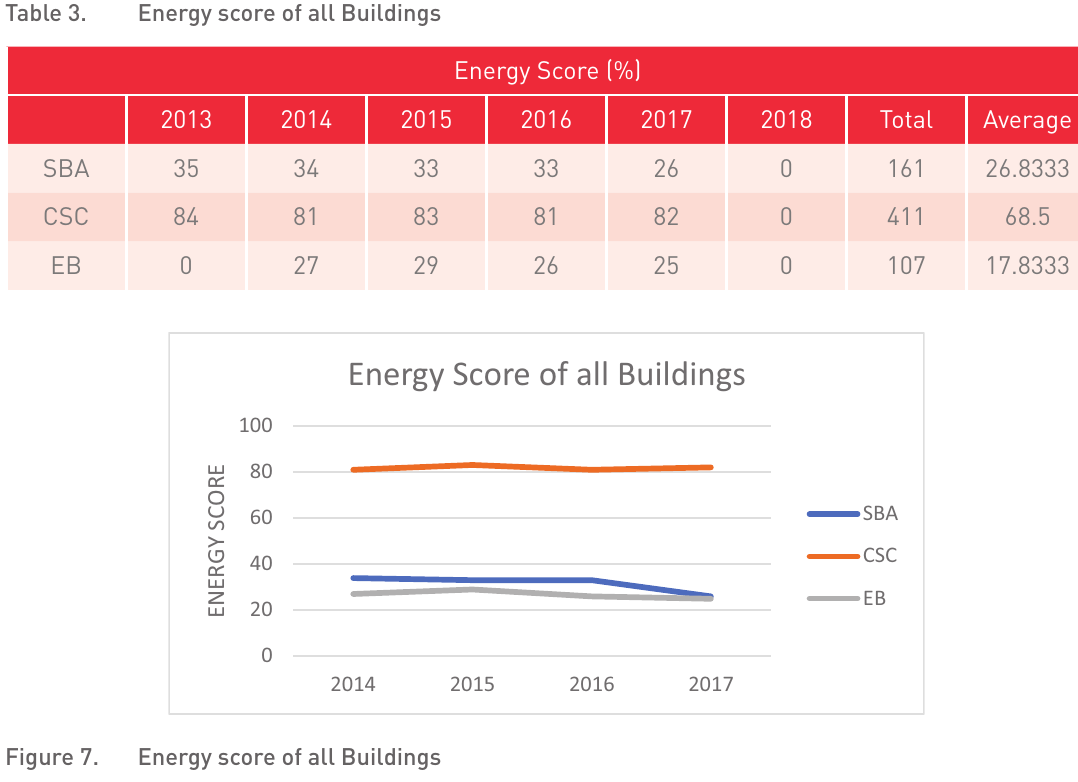
Energy score of all Buildings